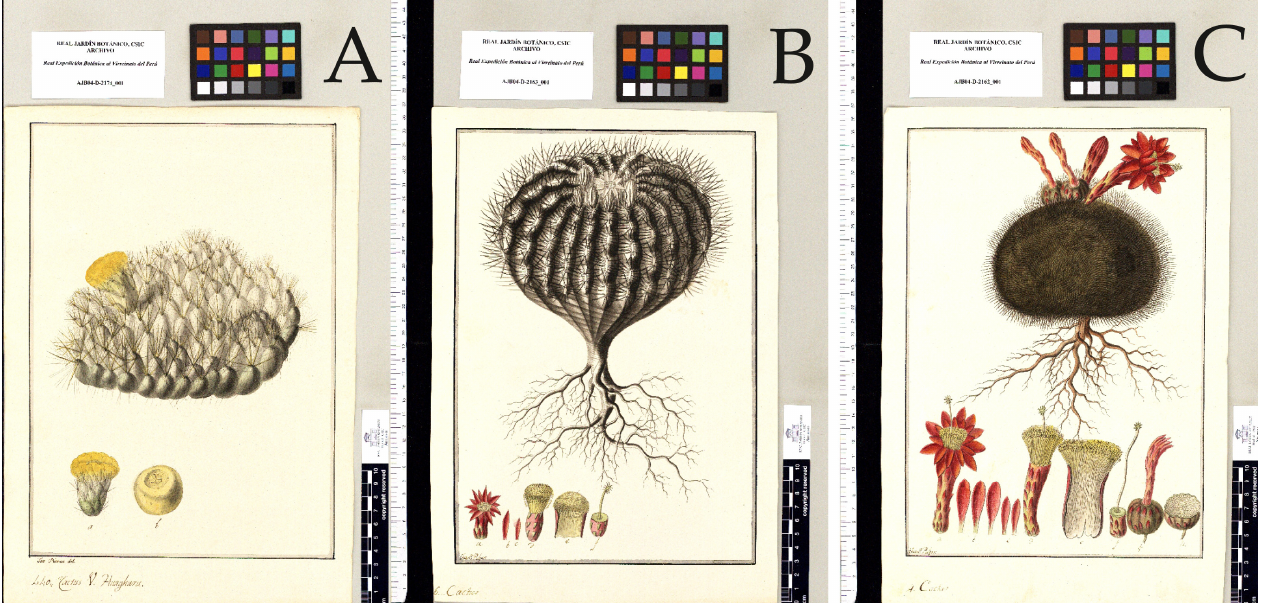
Figure 4. Drawings of Cactaceae from the RSBEVP, which are kept in the Royal Botanical Garden of Madrid (reproduction with permission). ( A ) Cactus Ruiz & Pav. (probably Austrocylindropuntia floccosa (Salm-Dyck) F. Ritter, ( B ) Cactus melocactus L. (= Oroya peruviana (K.Schum.) Britton & Rose) and ( C ) Cactus melocactus L. (probably Matucana haynii (Otto ex Salm-Dyck) Britton & Rose). The cryorotropical belt is not represented in the